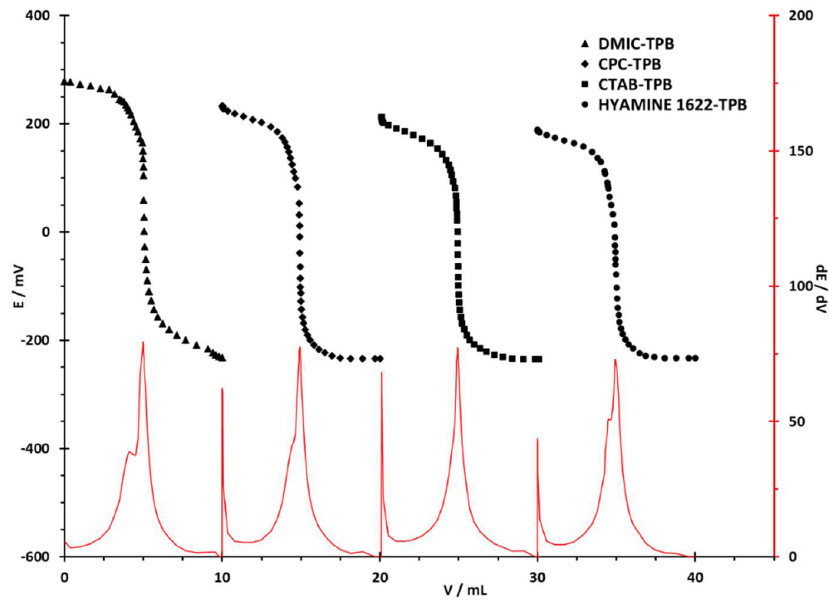
Figure 4. Potentiometric titration curves for 20 µ mol of cationic surfactant with TPB (4 × 10 − 3 M). First derivatives are presented in full as the red lines below the titration curves, with corresponding values on the secondary y axis. Table 3. Response characteristics for the DODI-TPB surfactant sensor to DMIC, CPC, CTAB, and Hyamine 1622 (mean values ± 95% confidence limits).